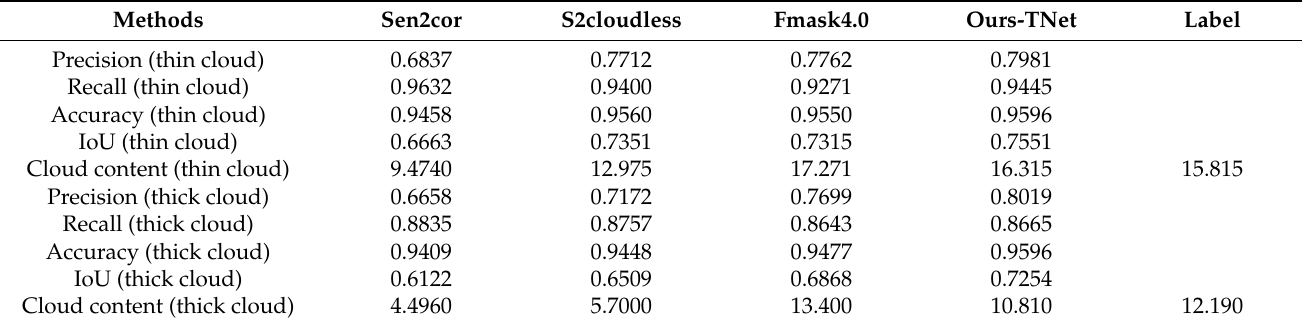
Table 1. Comparison of the accuracy of four cloud detection methods.